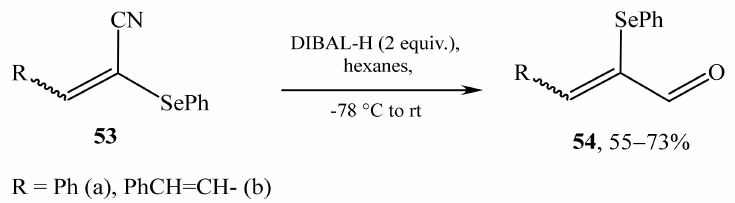
Scheme 21. Synthesis of 2-phenylselenoalkenals 54 .